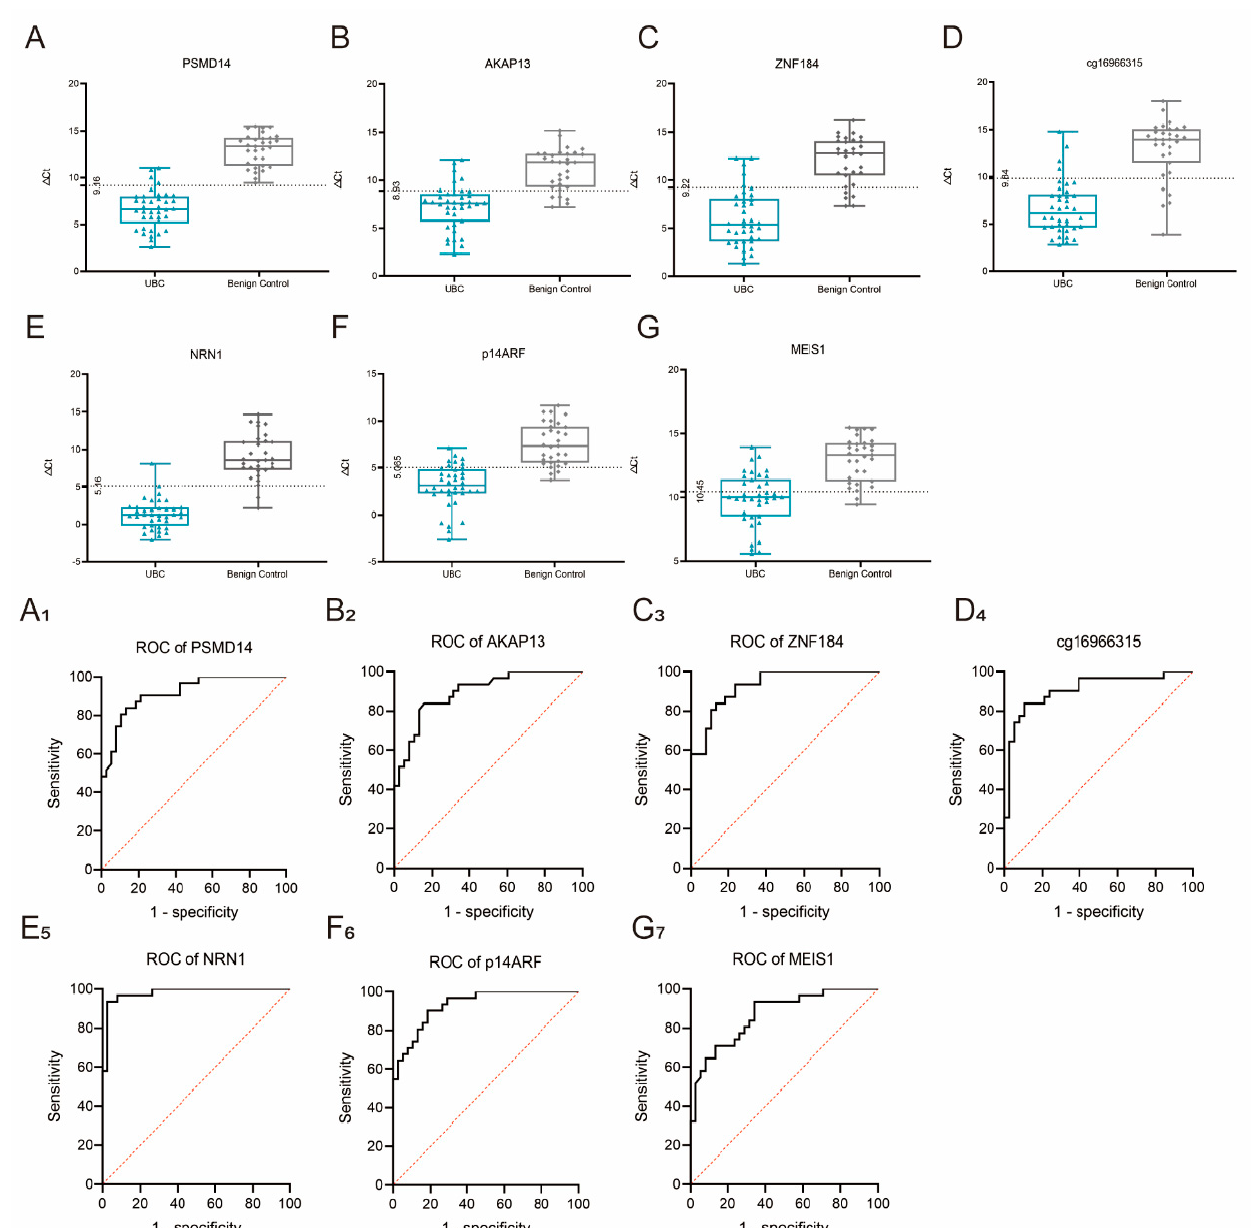
Figure 3. The box plot and AUC of different methylation biomarkers in cohort 2 by detecting meth ‐ ylation regions. ( A – G ) represents the Δ Ct value distributions of each biomarker in UBC and control groups. ( A1 – G7 ) represents the AUC values of each biomarker. The classifier of the AUC analysis was Δ ct value of biomarkers in each sample.